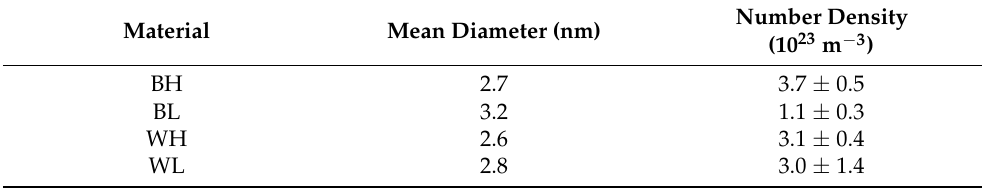
Table 6. Estimates of the mean diameter and number density of solute atom clusters located in the matrix. Errors are sample-to-sample variations.